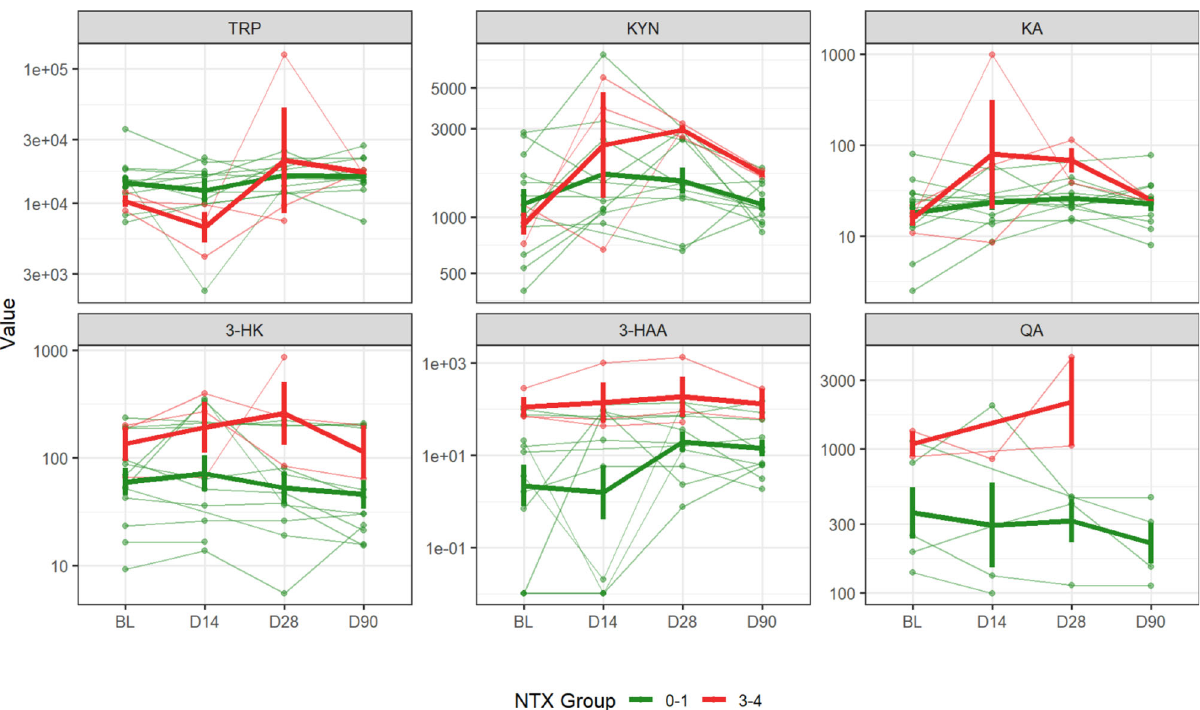
Fig. 3 Kynurenine metabolites over time compared between low neurotoxicity (grades 0 – 1) and high neurotoxicity (grades 3 – 4) groups. BL baseline, NTX Neurotoxicity, TRP Tryptophan, KYN Kynurenine, KA Kynurenic acid, 3-HK 3-Hydroxykynurenine, 3-HAA 3-Hydroxyanthranilic acid, QA Quinolinic acid. Observations from each subject ( n = 15) relate to thin lines. Thick lines relate to means with error bars indicating standard error. Linear mixed-effects model showed 3HAA and 3HK were elevated in patients with neurotoxicity grades over the study period ( p = 0.031 and p = 0.10, respectively).